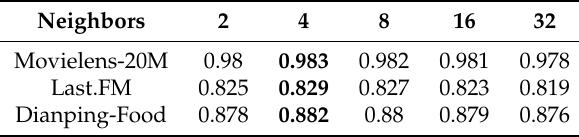
Table 6. Impact of different neighbor samples on AUC.